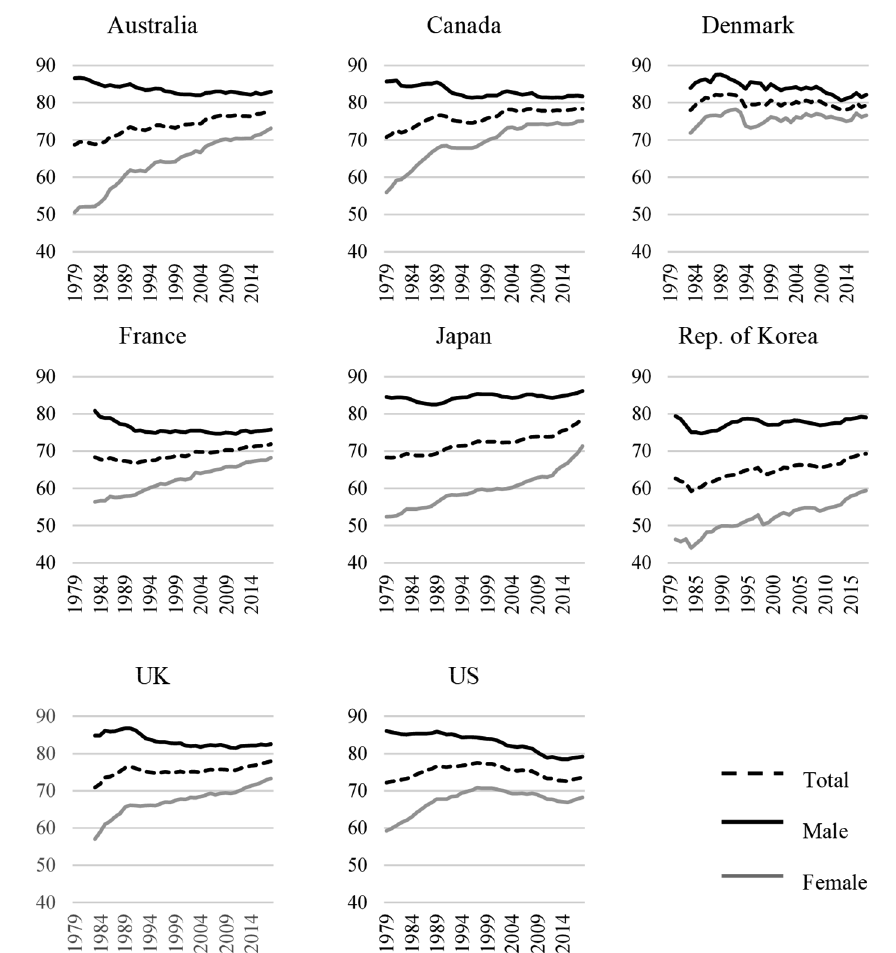
Figure 4. Participation rates of male and female (source: own calculations based on the ILO